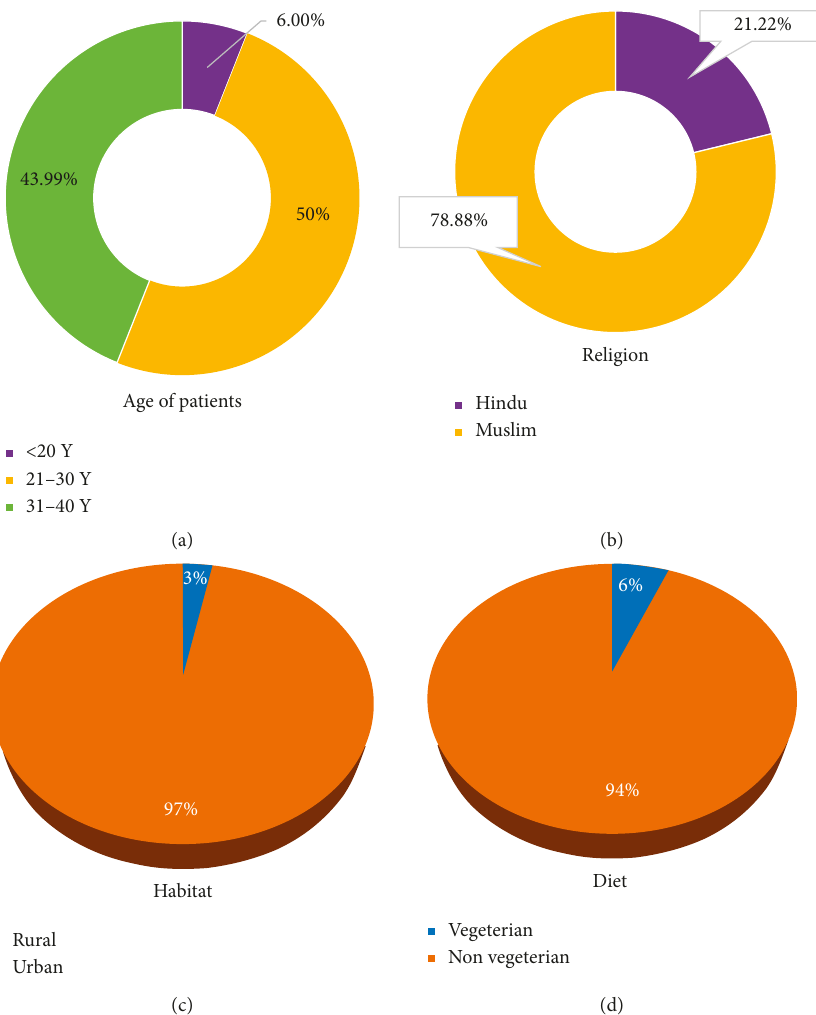
Figure 2: Demographic variables of patients with abnormal vaginal discharge. (a) Age of patients. (b) Religion. (c) Habitat. (d)